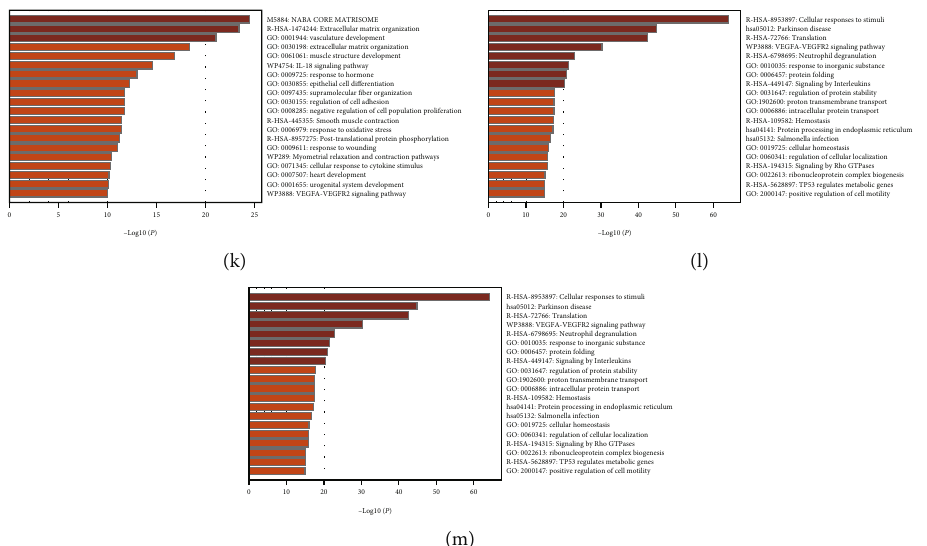
Figure 4: (a – m) Gene Ontology enrichment analysis of each